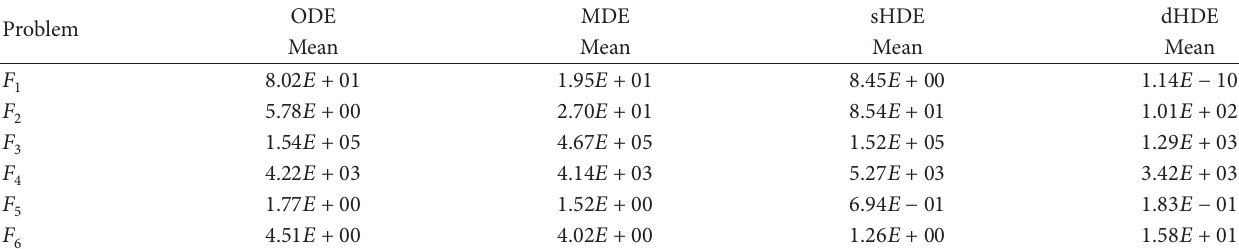
Table 6: Comparison of HDE with ODE and MDE on shifted large-scale benchmark